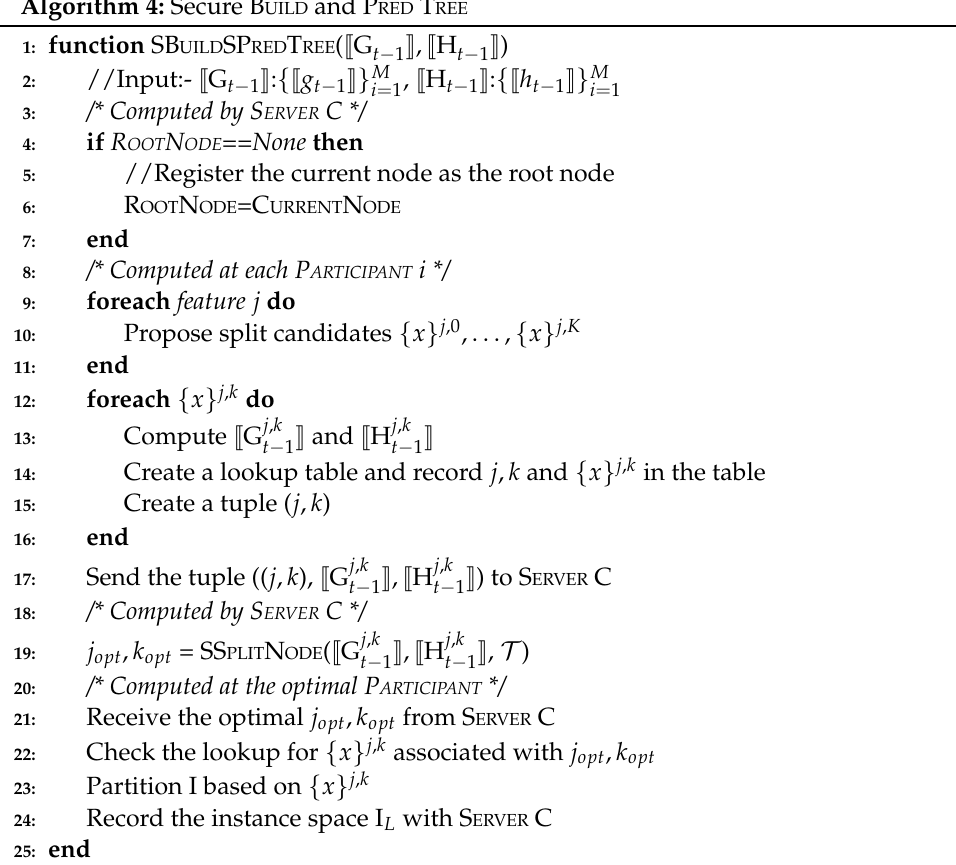
Algorithm 4: Secure B UILD and P RED T